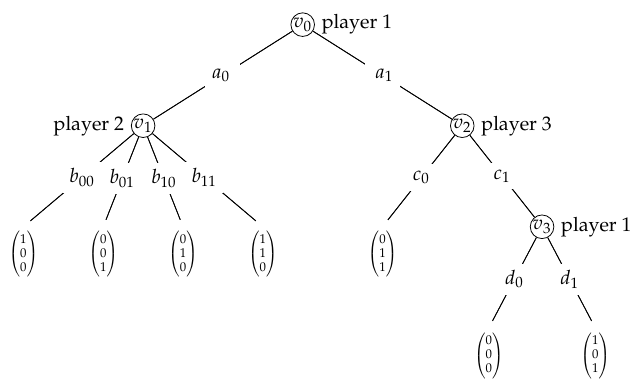
Figure 1. Extensive-form game of perfect information. The players are depicted besides the nodes at which they are active. Vertices are identified with histories, for instance, the root v 0 with () , vertex v 3 with a 1 c 1 , and the leaf node/terminal history labelled with a 0 b 00 , omitting parentheses and commas for better readability.